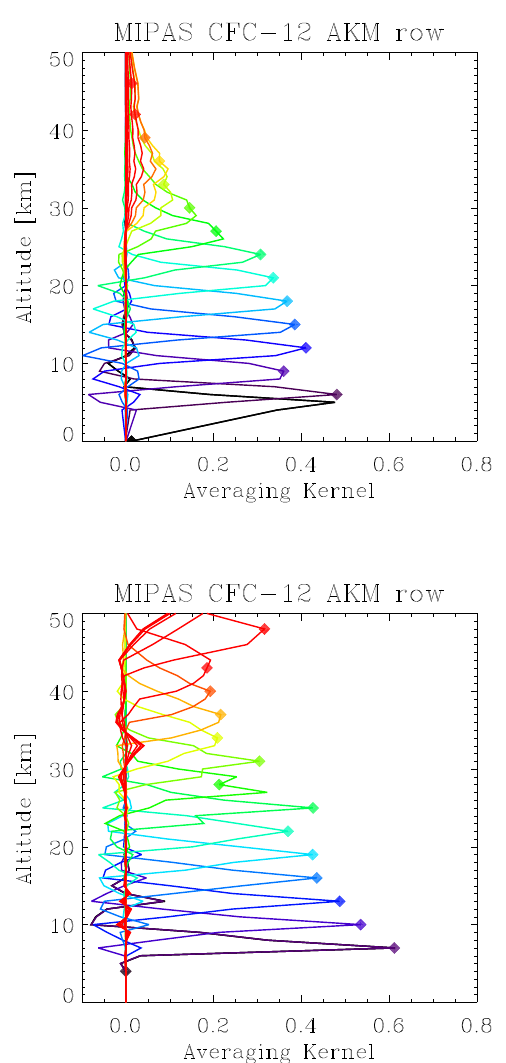
Fig. 2. Typical measured (black) and calculated (red) spectra of CFC-11 and the fit residual in 14 km in the 831 and 853 cm − 1 spectral region for the FR (top) and the RR (bottom) nominal mea- Fig. 3. Rows of averaging kernels of CFC-12 measurements for FR surement modes. nominal mode (top) and RR (bottom) nominal measurement modes. Fig. 3. Rows of averaging kernels of CFC-12 measurements for FR Diamonds represent the nominal altitudes (i.e. the diagonal value of nominal mode (top) and RR (bottom) nominal measurement modes. the averaging kernel matrix). Only every third kernel is shown. Diamonds represent the nominal altitudes (i.e. the diagonal value of the averaging kernel matrix). Only every third kernel is shown.